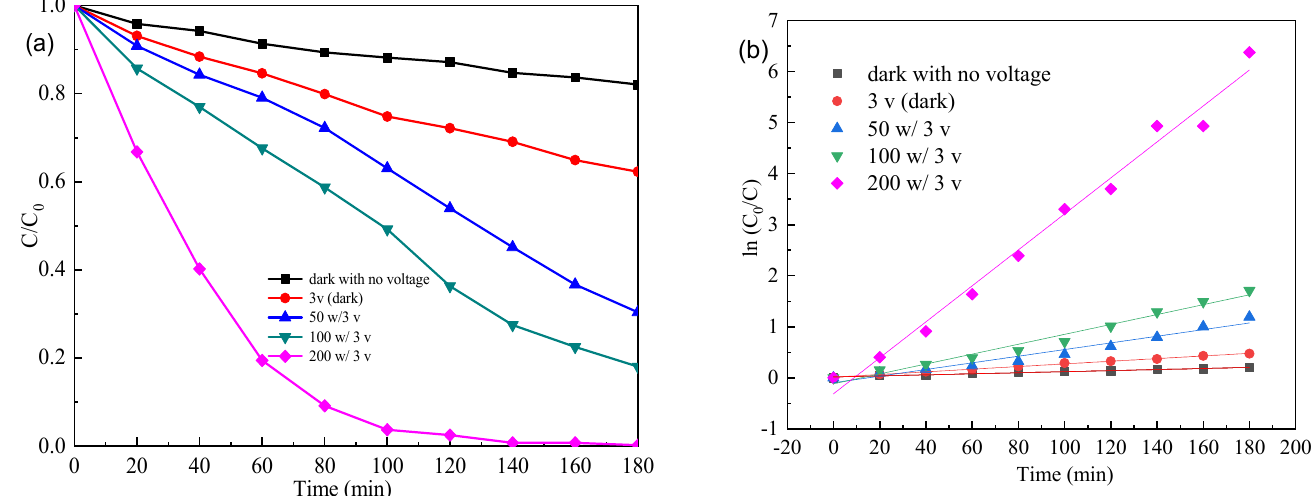
Figure 8. ( a ) Photo (electro) degradation of MB, ( b ) linear transform ln (C 0 /C) of the kinetic curves of MB by 25% Fw-Co(OH) 2/ g-C 3 N 4 at different visible light